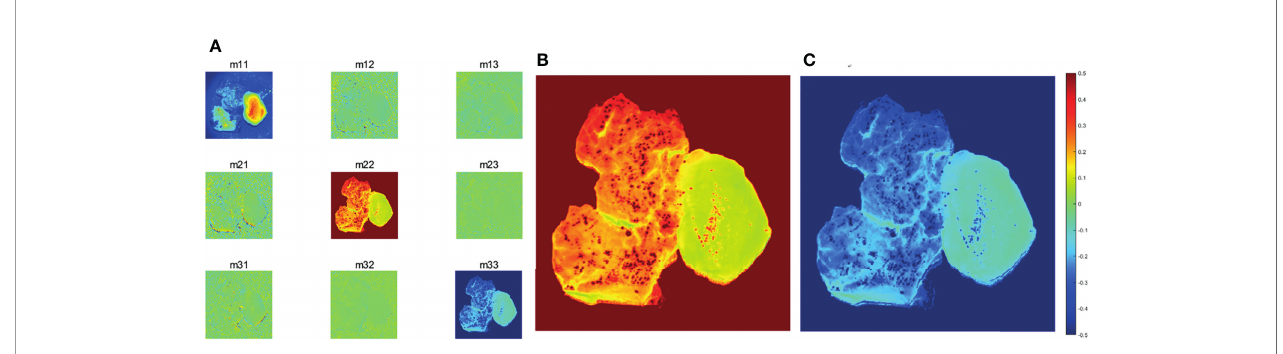
FIGURE 4 | (A) Images of 3×3 Mueller matrix elements of detected GBM samples with non-GBM brain tissue. All the Mueller matrix elements of the sample are (except m 11 ) divided by m 11 . (B) m 22 image of GBM samples with non-GBM brain tissue. (C) m 33 image of GBM samples with non-GBM brain tissue. The scale of the normalized elements is given by the